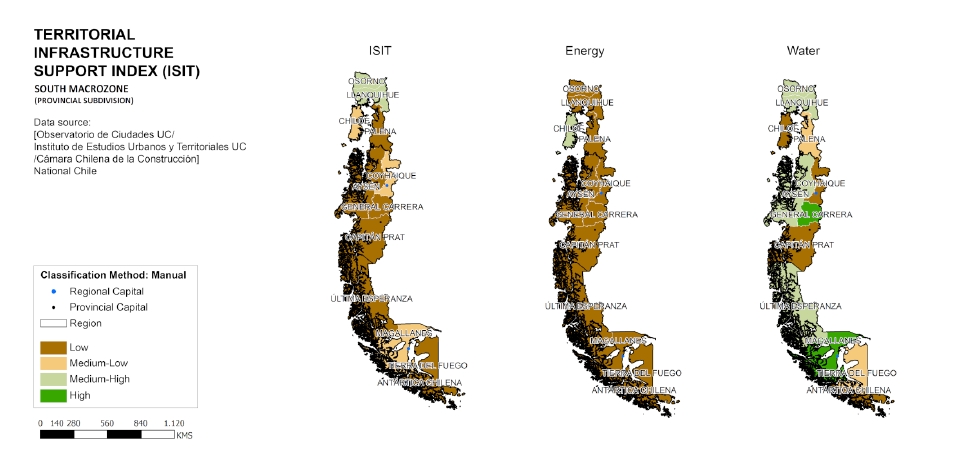
Figure 5: ISIT of provinces of the southern